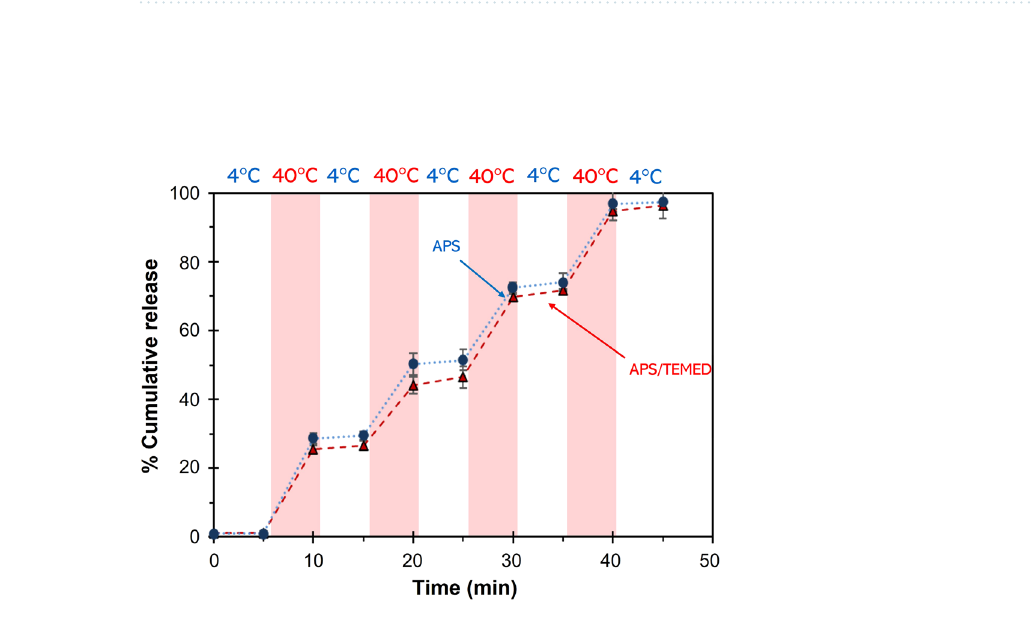
Figure 10. Thermoresponsive behavior of PNIPAM@RS100; visual observation of color change of emulsions and cumulative release of Nile Blue A at room temperature (25 °C) and the body temperature (37 °C) in DI water. The PNIPAM gating particles were prepared by ( a ) thermal and ( b ) redox initiating systems.